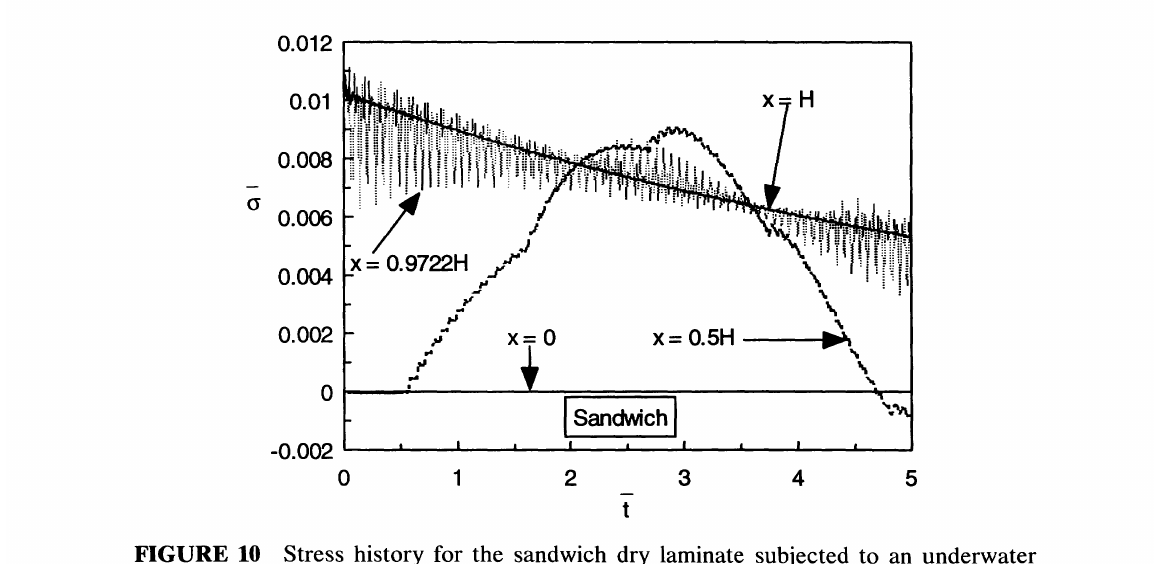
FIGURE 10 Stress history for the sandwich dry laminate subjected to an underwater explosion: TNT, 20 kg, D = 10